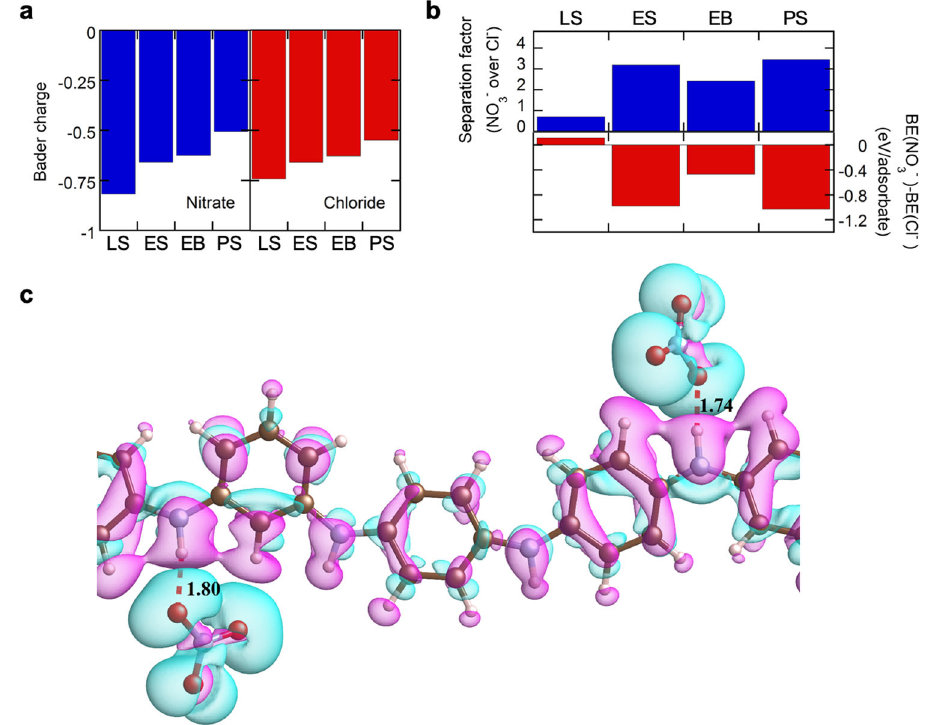
Fig. 5 | Electronic structure calculations on the binding between PANI and nitrate. a Atomic Bader charges ofNO 3 − /Cl − species bonded to the PANI. The total Baderchargewas calculated on theoptimizedadsorbates-PANIstructures, andthe average values of NO 3 − and Cl − are presented. b Separation factors toward nitrate over chloride and difference in binding energies (BEs) for nitrate and chloride to